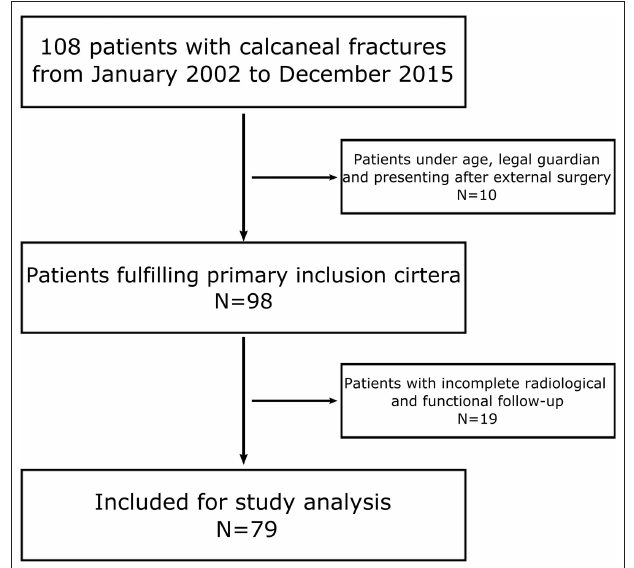
FIGURE 1 | Flow diagram demonstrating the patients included for the study